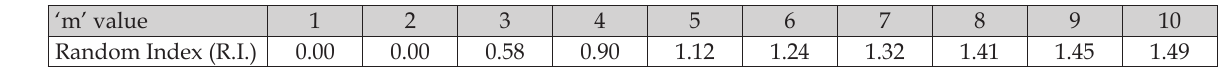
Table 3. Random Index for different ‘m’ values.